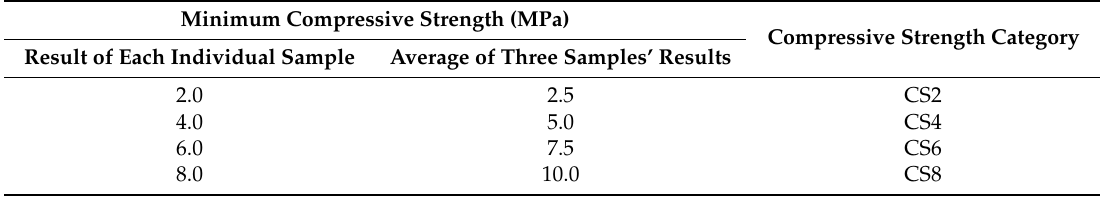
Table 13. Compressive strength of non ‐ bearing concrete in accordance with ISO 7782 style.